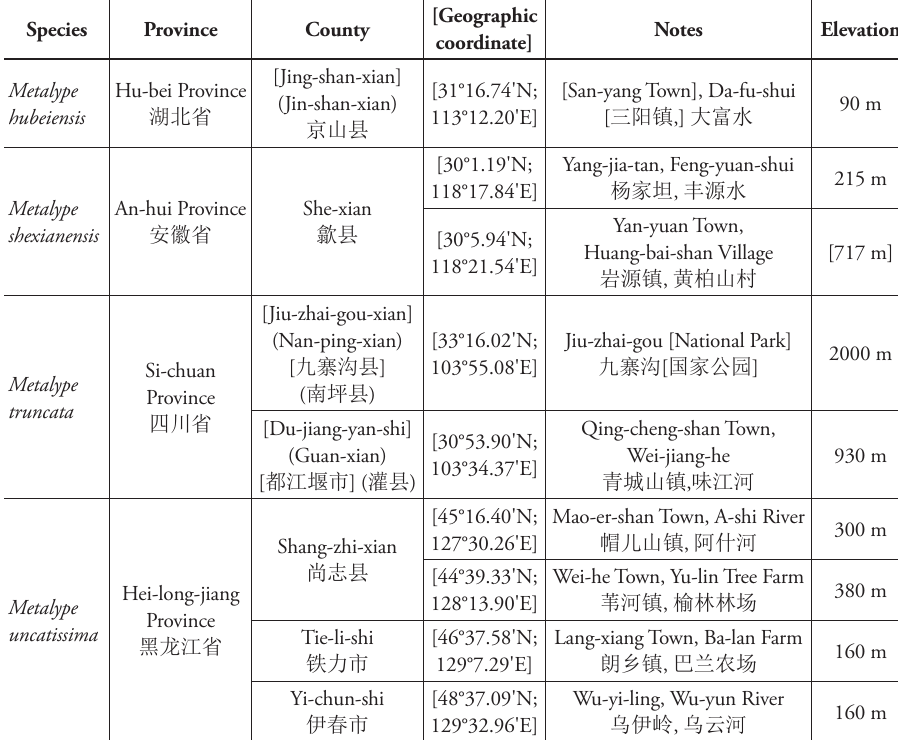
Table 1. Locations of Metalype species from